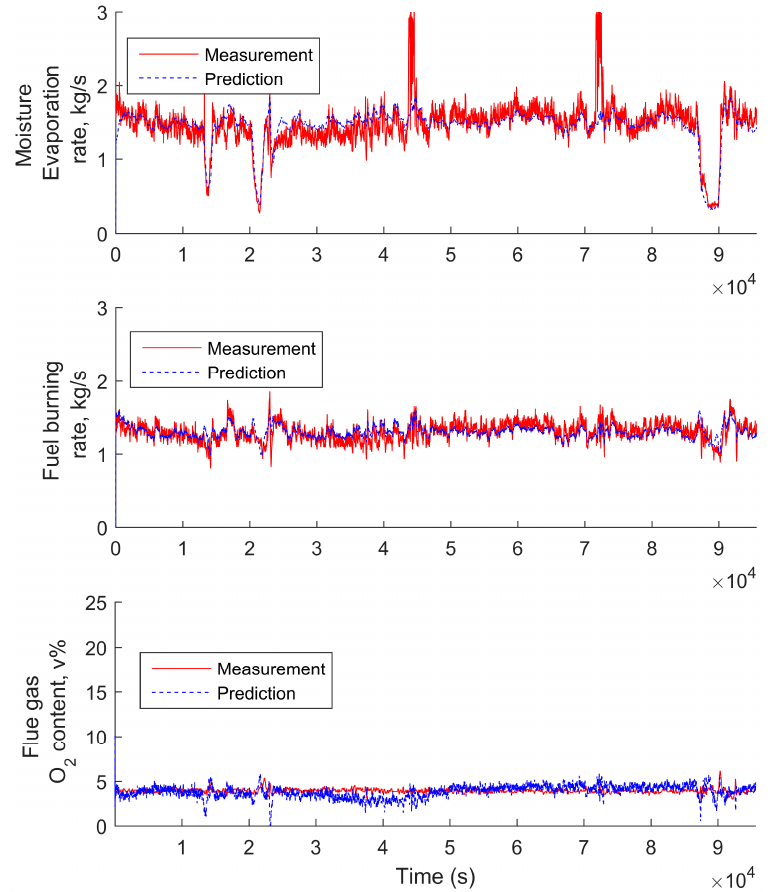
Figure 6. Measured and predicted outputs: moisture evaporation rate, fuel burning rate and flue gas content.